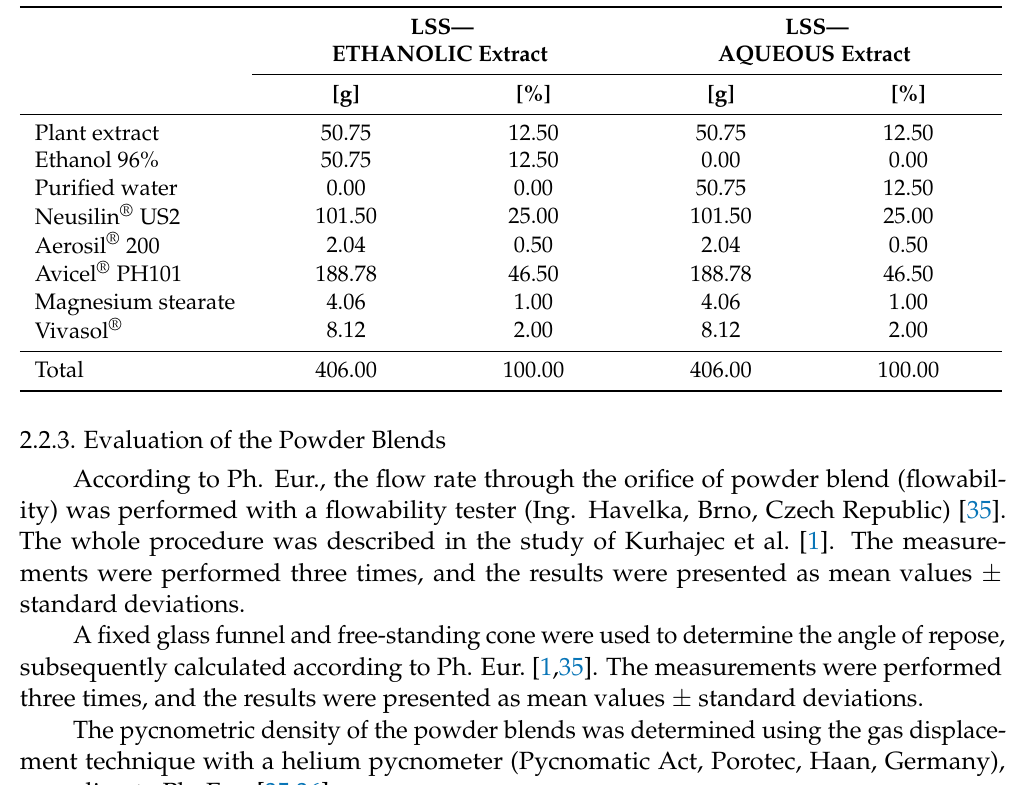
Table 2. Composition of the powder